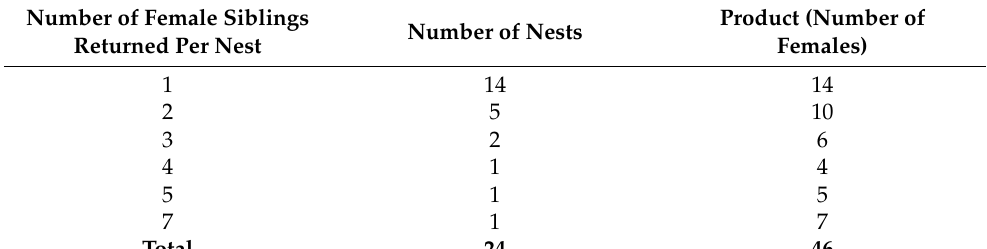
Table 2. The number of hatchling-marked sibling Northern Map Turtles per nest that returned to Mount Union as adult females during 2017–2022, from 24 nests protected during 2000–2008. Twenty nests were associated with known mothers, and four nests were found after completion; thus, their mothers are unknown. One female (ABDY) produced five hatchlings from one nest and two hatchlings from another nest—seven years apart—that returned as adult females.